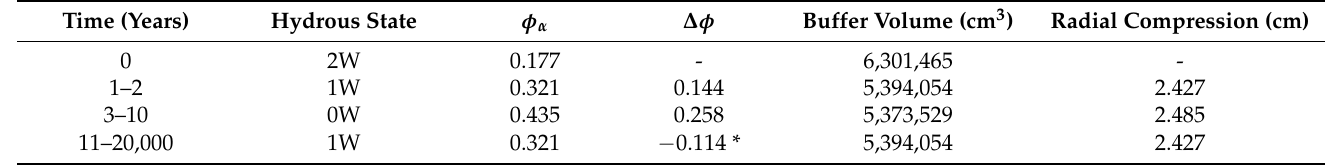
Table 7. Variations with time of the buffer volume and compression